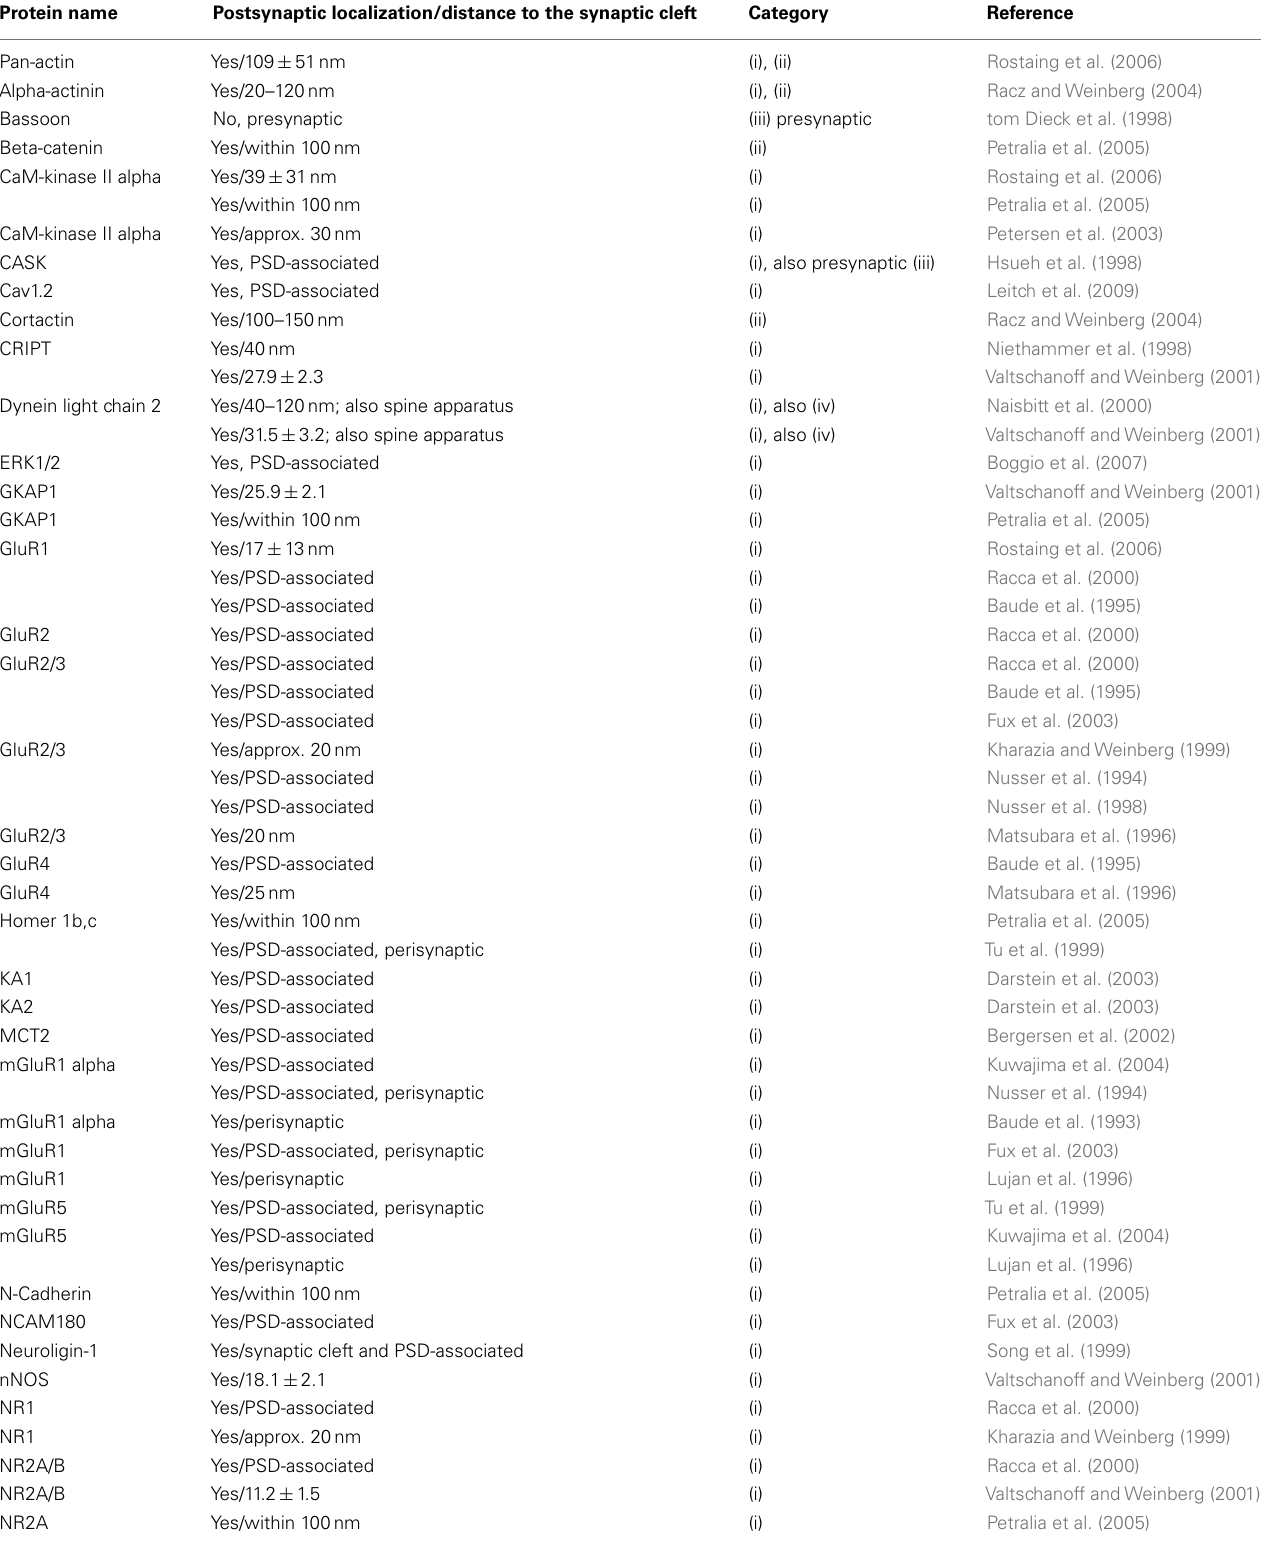
Table 4 | Ultrastructural localization of proteins present in detergent-resistant synaptic junctions